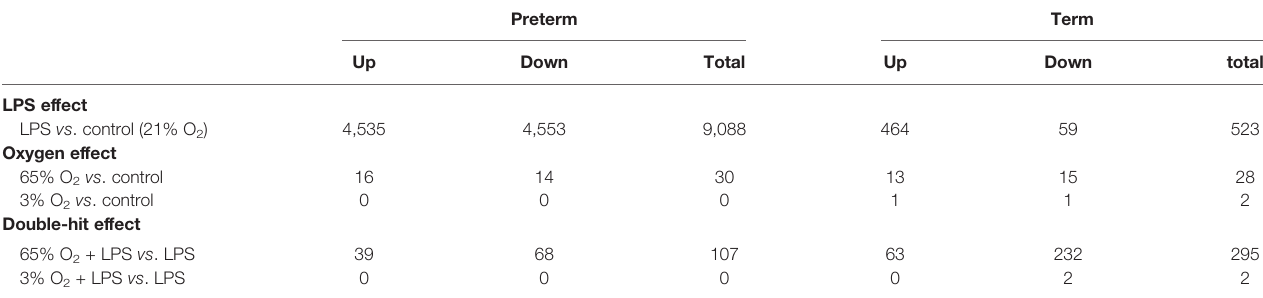
TABLE 1 | Numbers of differentially expressed genes in preterm and term macrophages exposed to various oxygen concentrations and